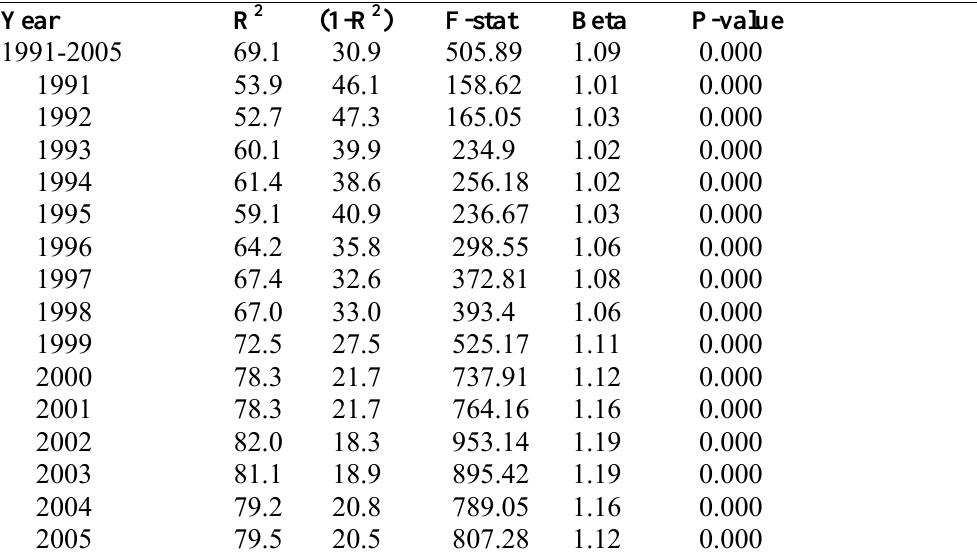
Model: NOSHLnVOLLn εβα ++= )()( iiii Vol = £ volume of shares traded; NOSH = number of shares outstanding; measures are mean annual results based on monthly regressions described by the